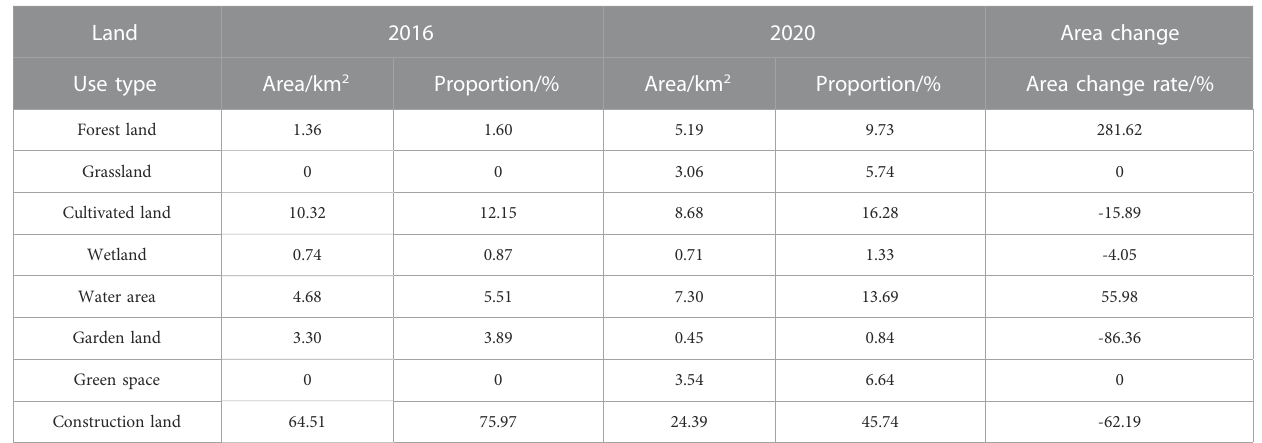
TABLE 3 Changes of land use area of the study area in